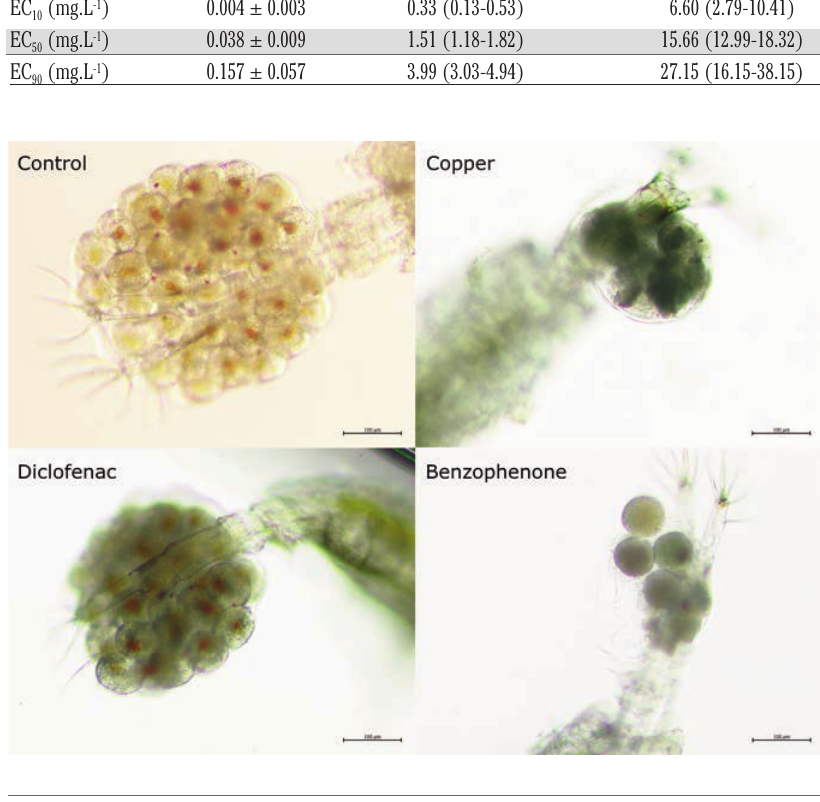
Figure 1. Pictures of copepods showing the effects of exposures to copper, benzophenone, and diclofenac compared to control.